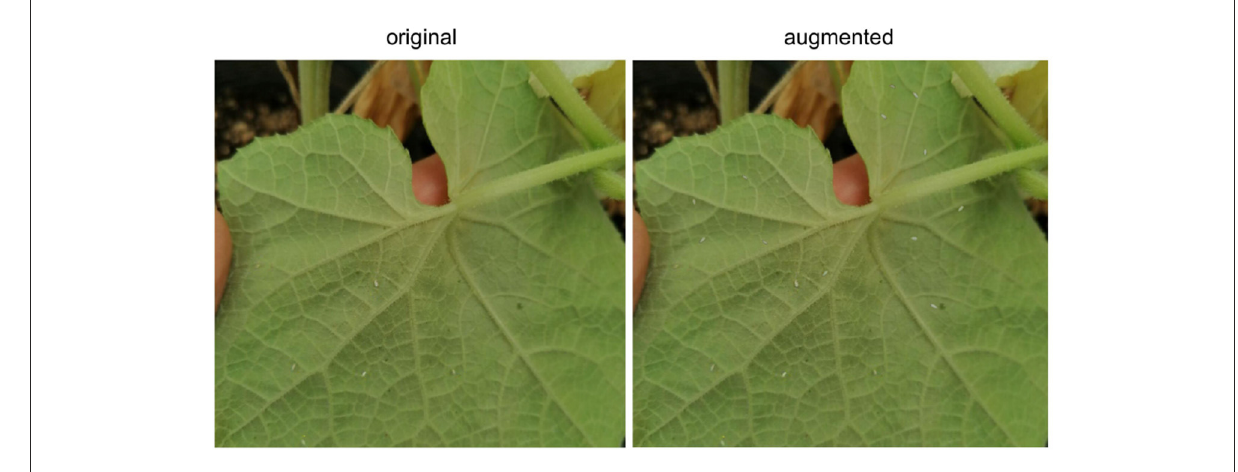
FIGURE3 CPB + GAN output